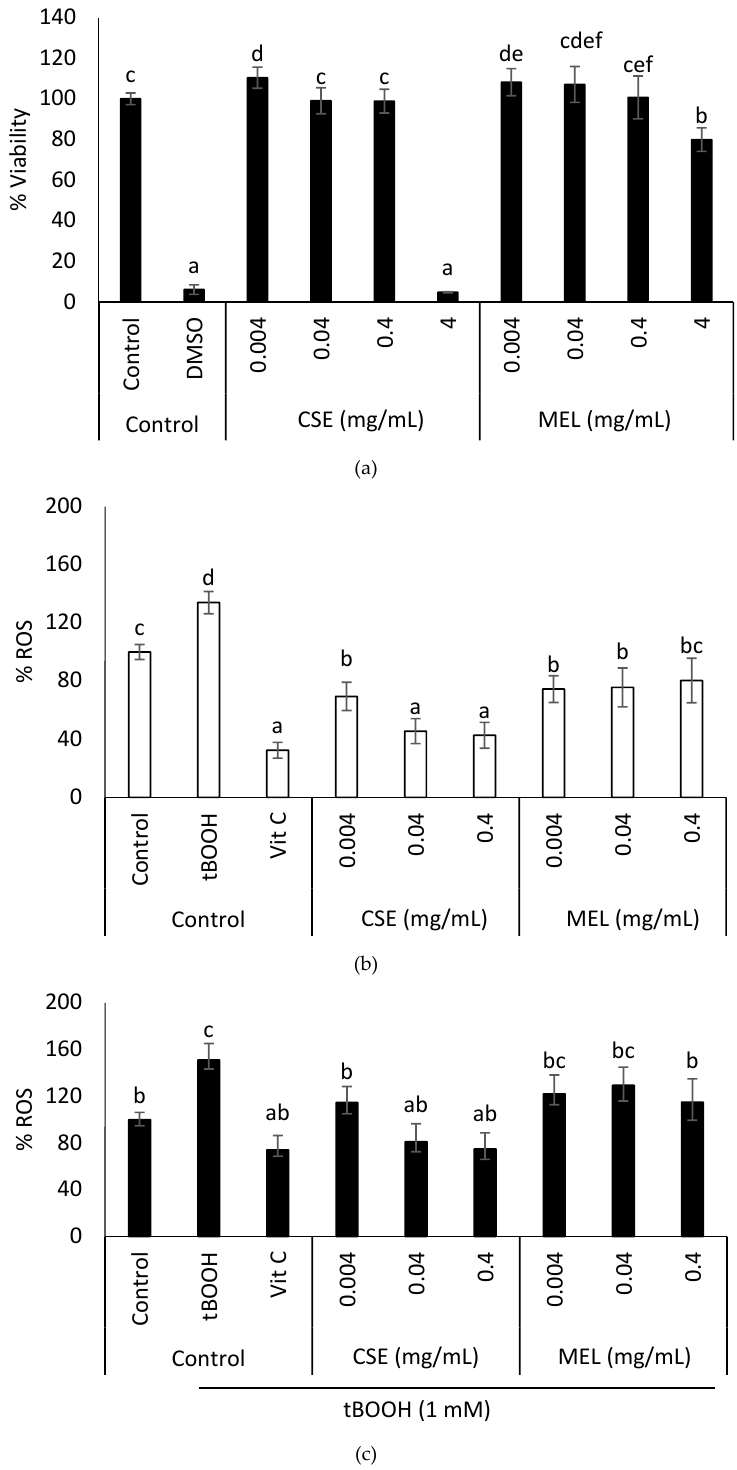
Figure 3. Effect of CSE and MEL on IEC-6 ( a ) cell viability, ( b ) physiological ROS, and ( c ) induced intracellular ROS. Cells were cultured with different concentrations of CSE or MEL, for 24 h. Then, the MTT assay was performed to determine cell viability and ROS were measured using the DCFH-DA probe. Control—untreated cells; death control—DMSO (50%); oxidation control—tBOOH (1 mM); antioxidant control—vitamin C (10 µ g/mL). Data are shown as the mean ± SEM of the three independent experiments. Different letters above columns indicate significant differences among treatments (Tukey test, p ≤